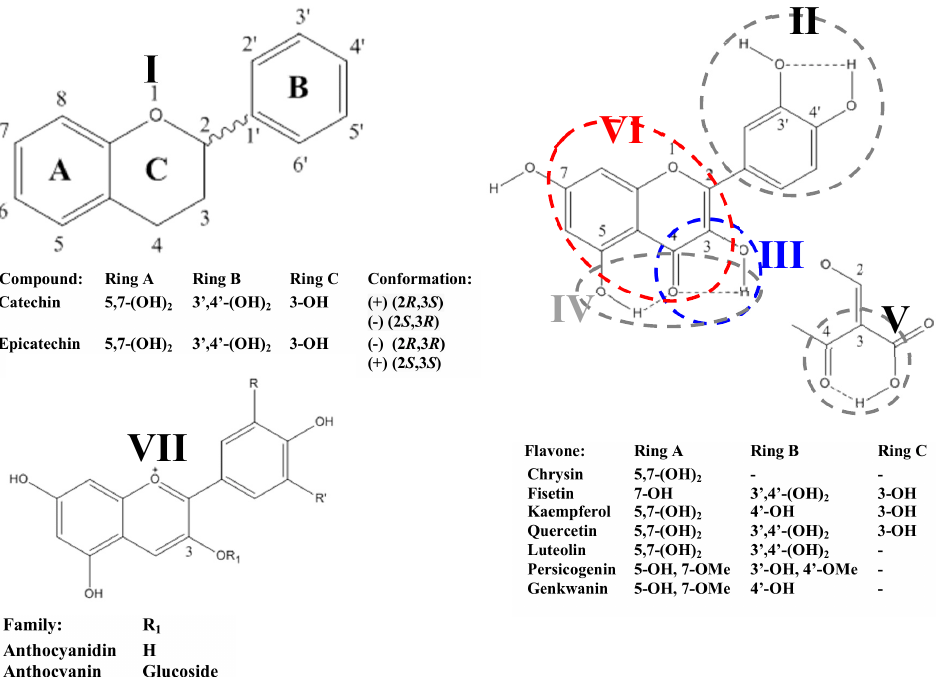
Figure 3. Representative structures for flavonoids: ( I ) flavonoid moiety; ( II ) catechol moiety; ( III ) representation of the intramolecular H-bond formed by 3-OH (Blue); ( IV ) representation of the simultaneous H-bonds formed by 3-OH and 5-OH (Grey); ( V ) representation of the six-atom extra ring formed due to a 3-COOH; ( VI ) chromone moiety (Red); ( VII ) generic representative structure for anthocyanins. Substitution patterns for some derivatives are included.